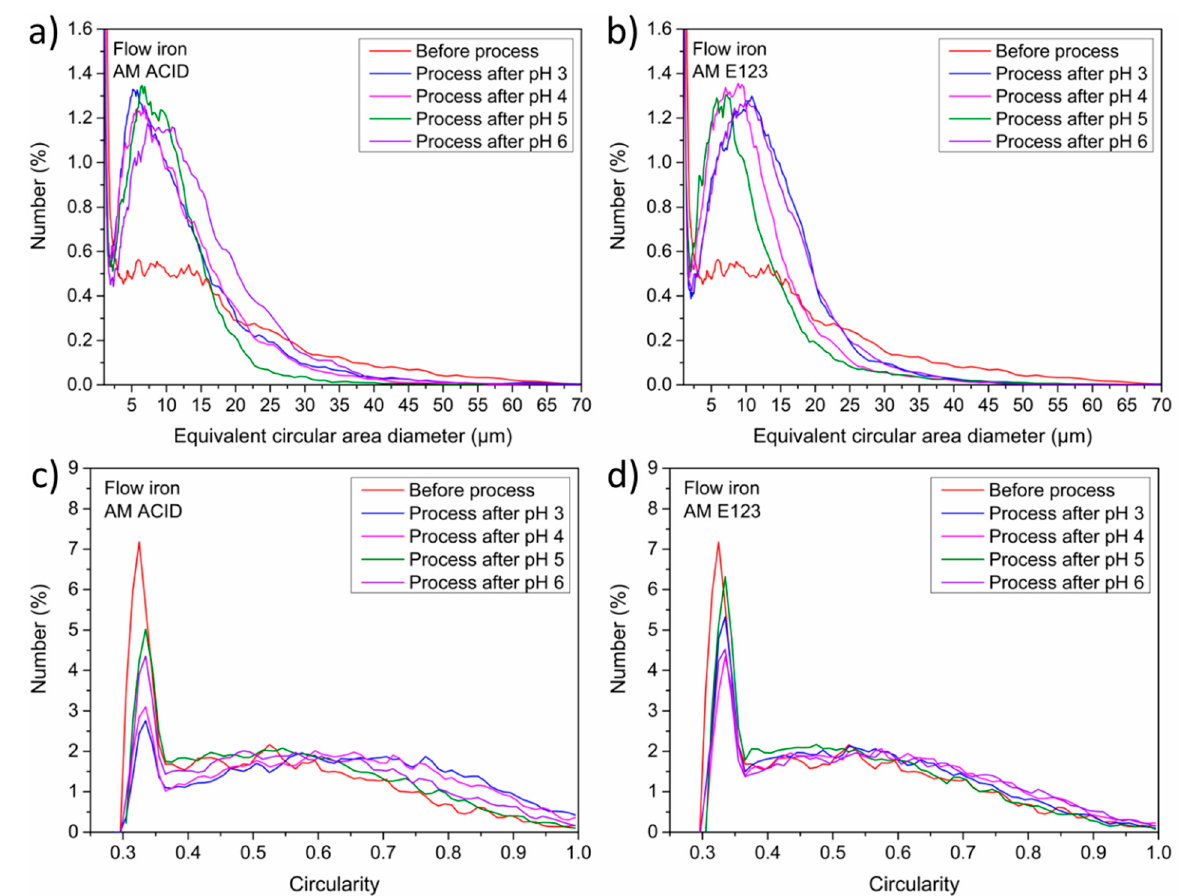
Figure 8. Comparison of shape parameters such as minimum equivalent circular area diameter for samples after the process with ( a ) AM ACID and ( b ) AM E123. Circularity of the material's grain after methods with ( c ) AM ACID and ( d ) AM E123.